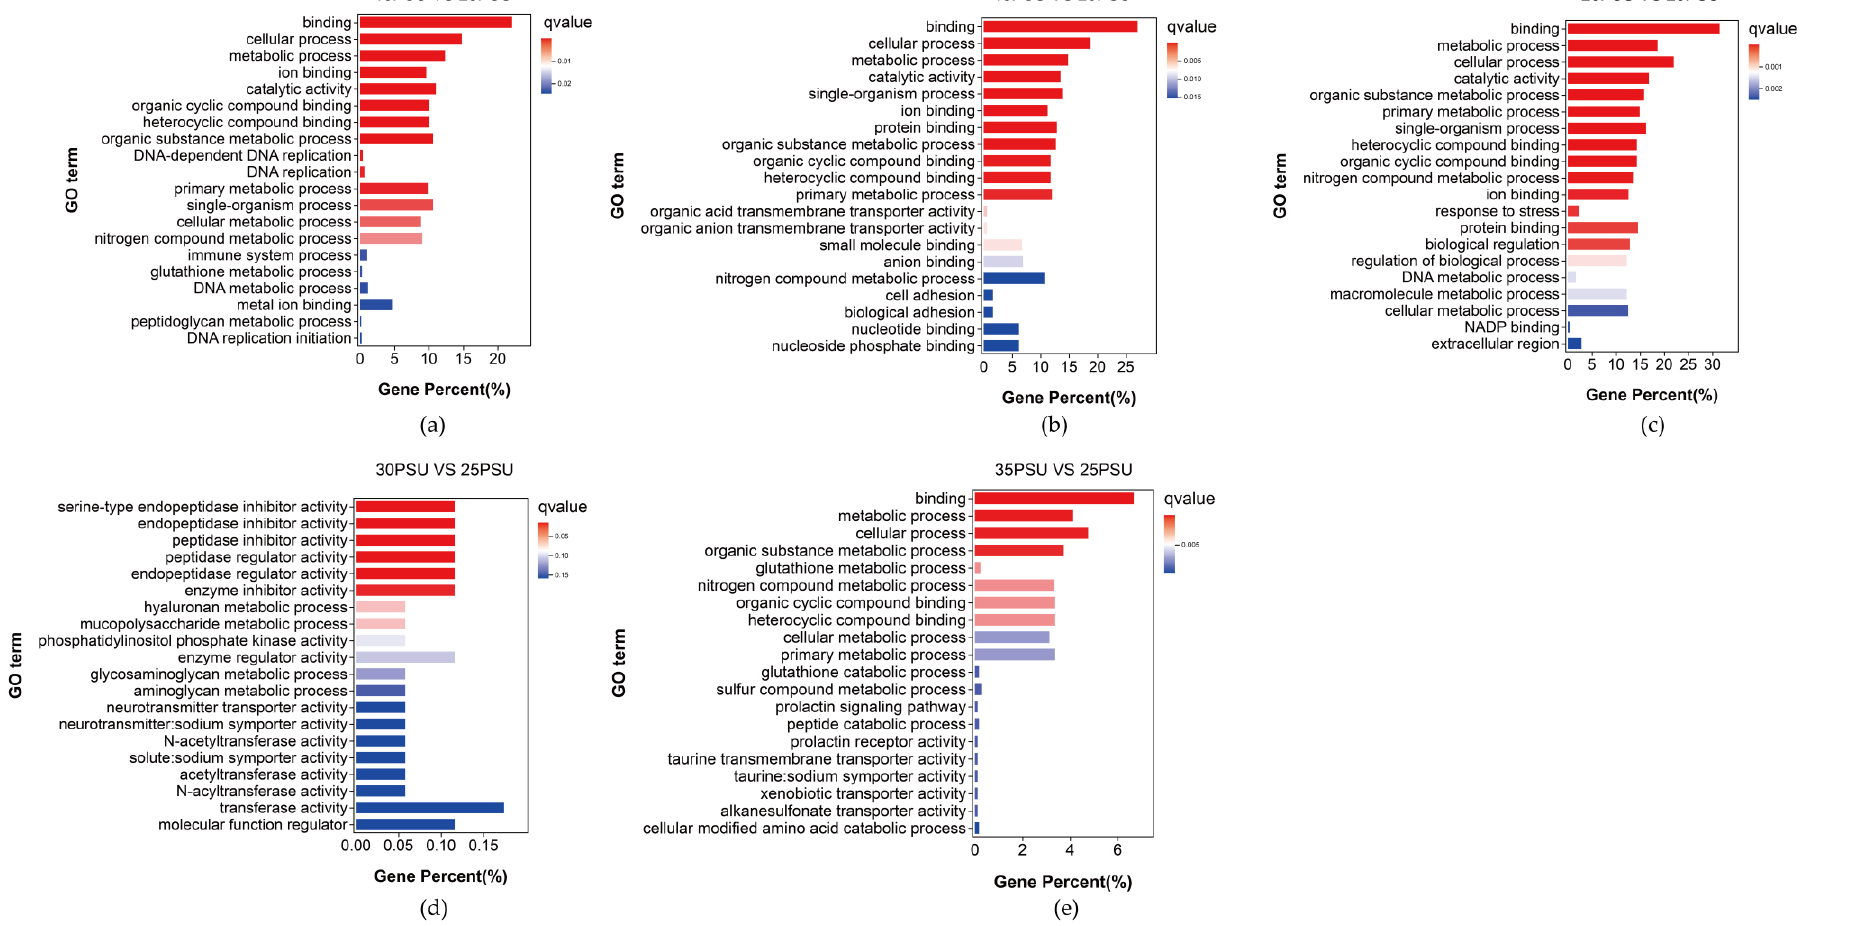
Figure 3. The results of the GO enrichment analysis of the DEGs in the yellow drum under salinity fluctuations. ( a ) 10PSU vs. 25PSU; ( b ) 15PSU vs. 25PSU; ( c ) 20PSU vs. 25PSU; ( d ) 30PSU vs. 25PSU; ( e ) 35PSU vs.